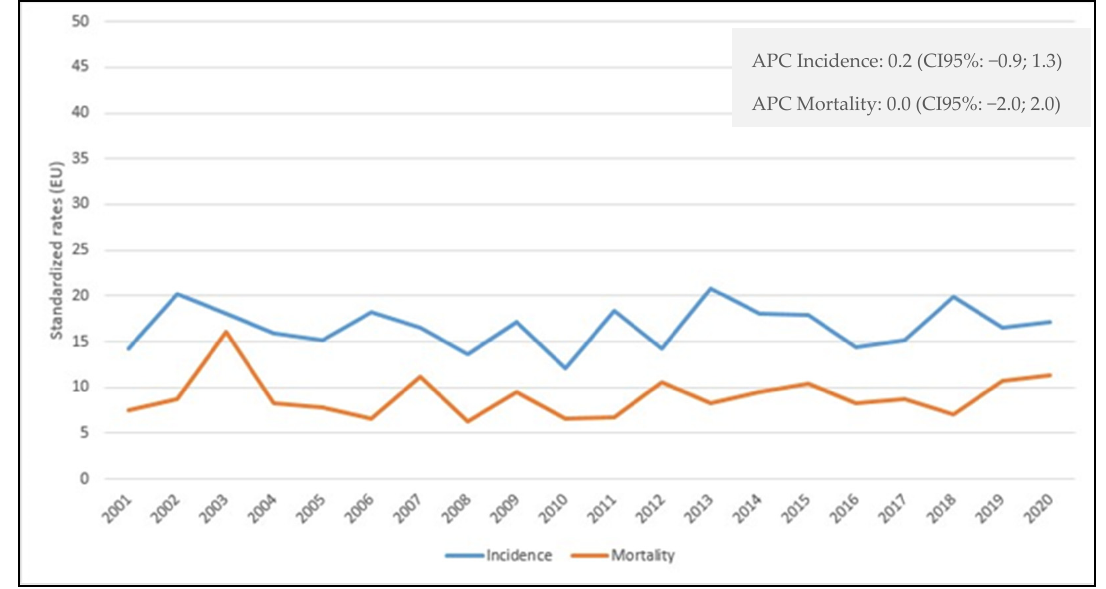
Figure 1. Age-standardized incidence and mortality rates per 100,000 person-years in the Province of Reggio Emilia in the period 2001–2020. Table 1. Distribution of cases by age, diagnosis, stage, and treatment. Years 2012–2018.